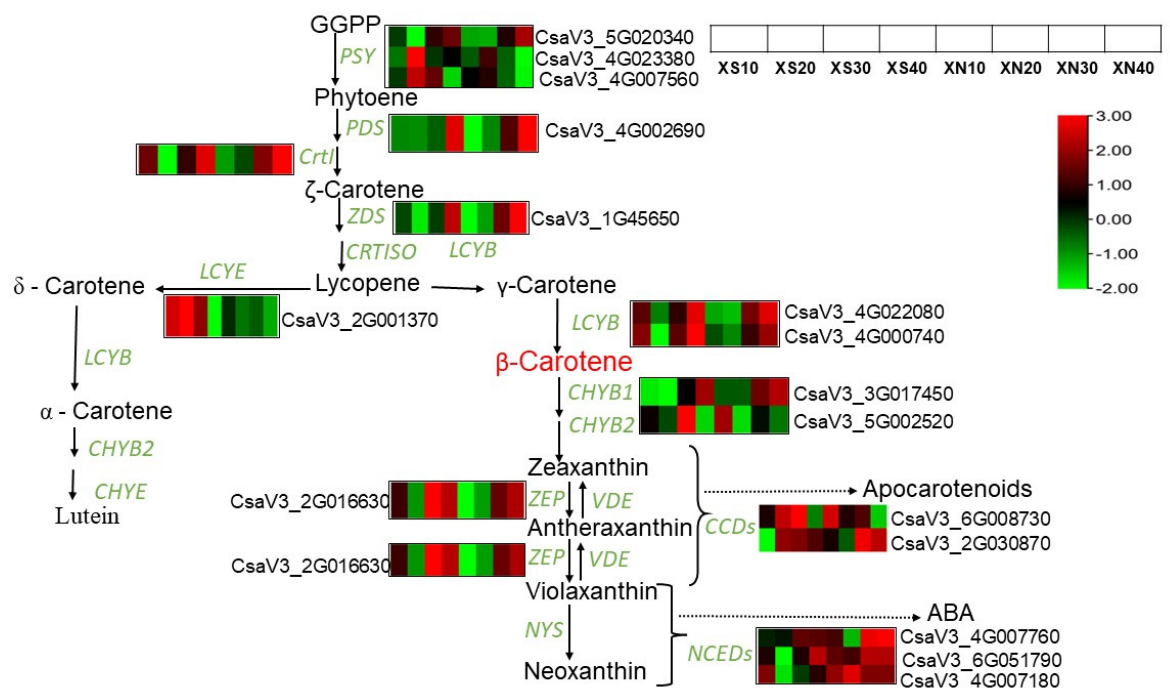
Figure 6. A schematic representation of the carotenoid biosynthetic pathway leading to carotenoid accumulation and degradation. The figure shows the expression pattern of each structural gene involved in carotenoid synthesis in XIS during fruit growth stages under photoperiod regimes. The color scale represents re-processed log10 (FPKM) using Pheatmap, representing the relative expression levels. The expression variance for each gene is indicated by colors ranging from low ( green ) to high ( red ). Geranylgeranyl diphosphate (GGPP); Phytoene synthase ( PSY ); Phytoene desaturase ( PDS ); Zeta-carotene Isomerase ( CrtI ); Zeta-carotene desaturase ( ZDS ); Carotene Iso- merase ( CRTISO ); lycopene- β - cyclase ( LYB ); lycopene- ε - cyclase ( LYE ); carotenoid β -hydroxylase ( CHYB ); carotenoid- ε -hydroxylase ( CHYE ); Zeaxanthin epoxidase ( ZEP ); Violaxanthin de-epoxidase ( VDE ); Neoxanthin synthase ( NYS ); carotenoid cleavage dioxygenase (CCD ); 9-cis-epoxycarotenoid dioxygenases ( NCEDs ); Abscisic acid